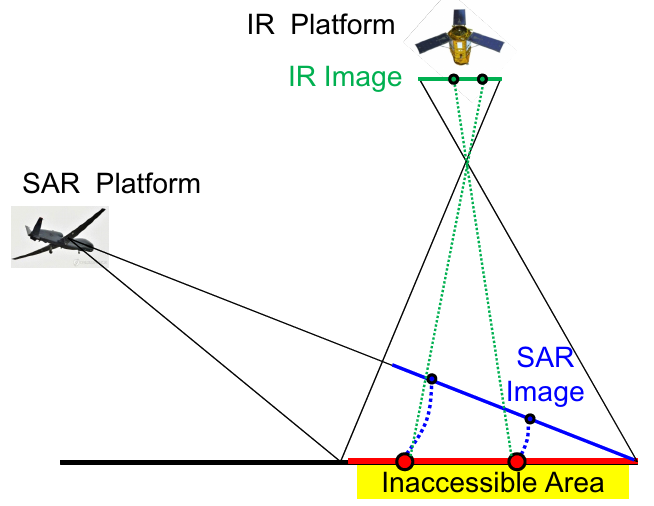
Figure 1. Operational concept of automatic target detection for inaccessible area